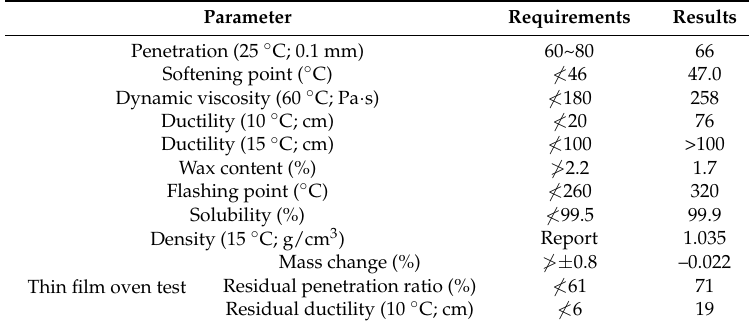
Table 1. Properties of matrix asphalt.